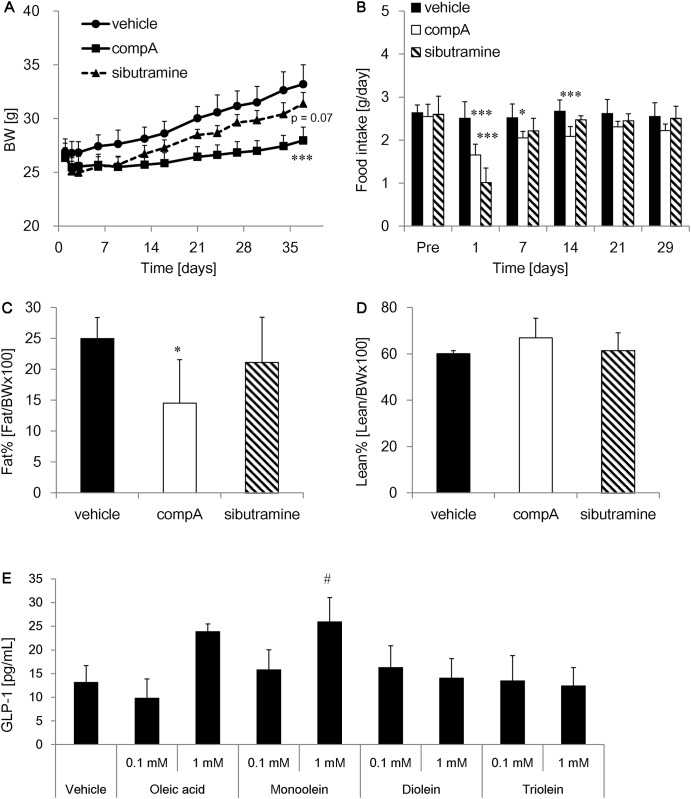
Anti-obesity effects of compA in C57BL/6J mice fed a high-fat diet (HFD).Male C57BL/6J mice were fed HFD and orally administered vehicle, 30 mg/kg compA, or 10 mg/kg sibutramine for 5 weeks. (A) Time course of changes in body weight (BW). (B) Food intake. Mean (C) fat mass and (D) lean mass. n = 6. *: P < 0.05, ***: P < 0.001 vs. WT mice by two-tailed Dunnett’s test. The results of Fig 4D were analyzed using two-tailed Steel’s test. (E) GLUTag cells were treated with assay buffer containing free fatty acid (oleic acid), monoacylglycerol (2-monoacylglycerol), diacylglycerol (diolein), and triglyceride (triolein) for 2h. Secreted GLP-1 levels in the assay buffer was measured by GLP-1 ELISA. n = 4. #: P < 0.025 vs. control by one-tailed Williams test.